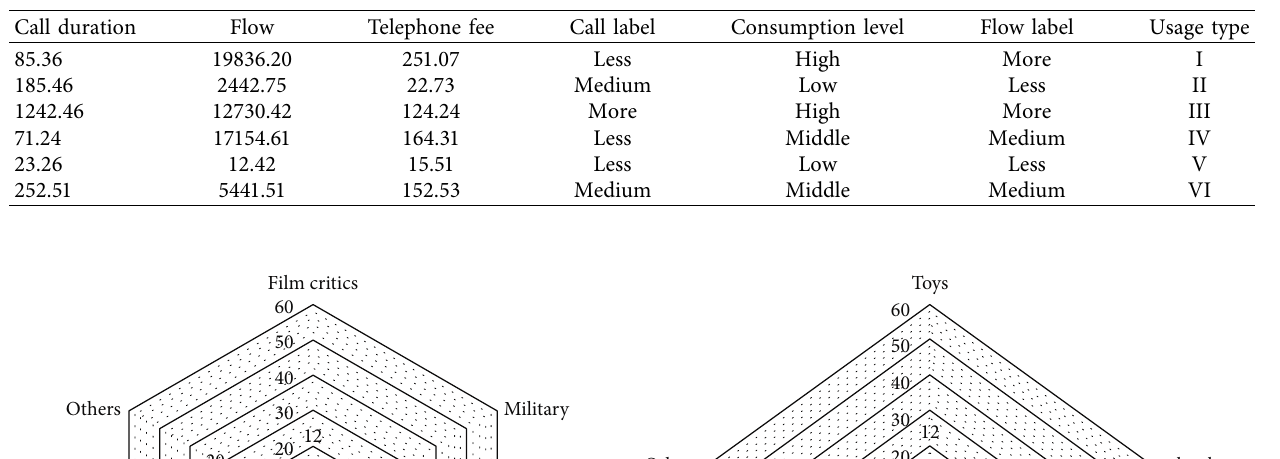
Table 1: Cluster analysis results.